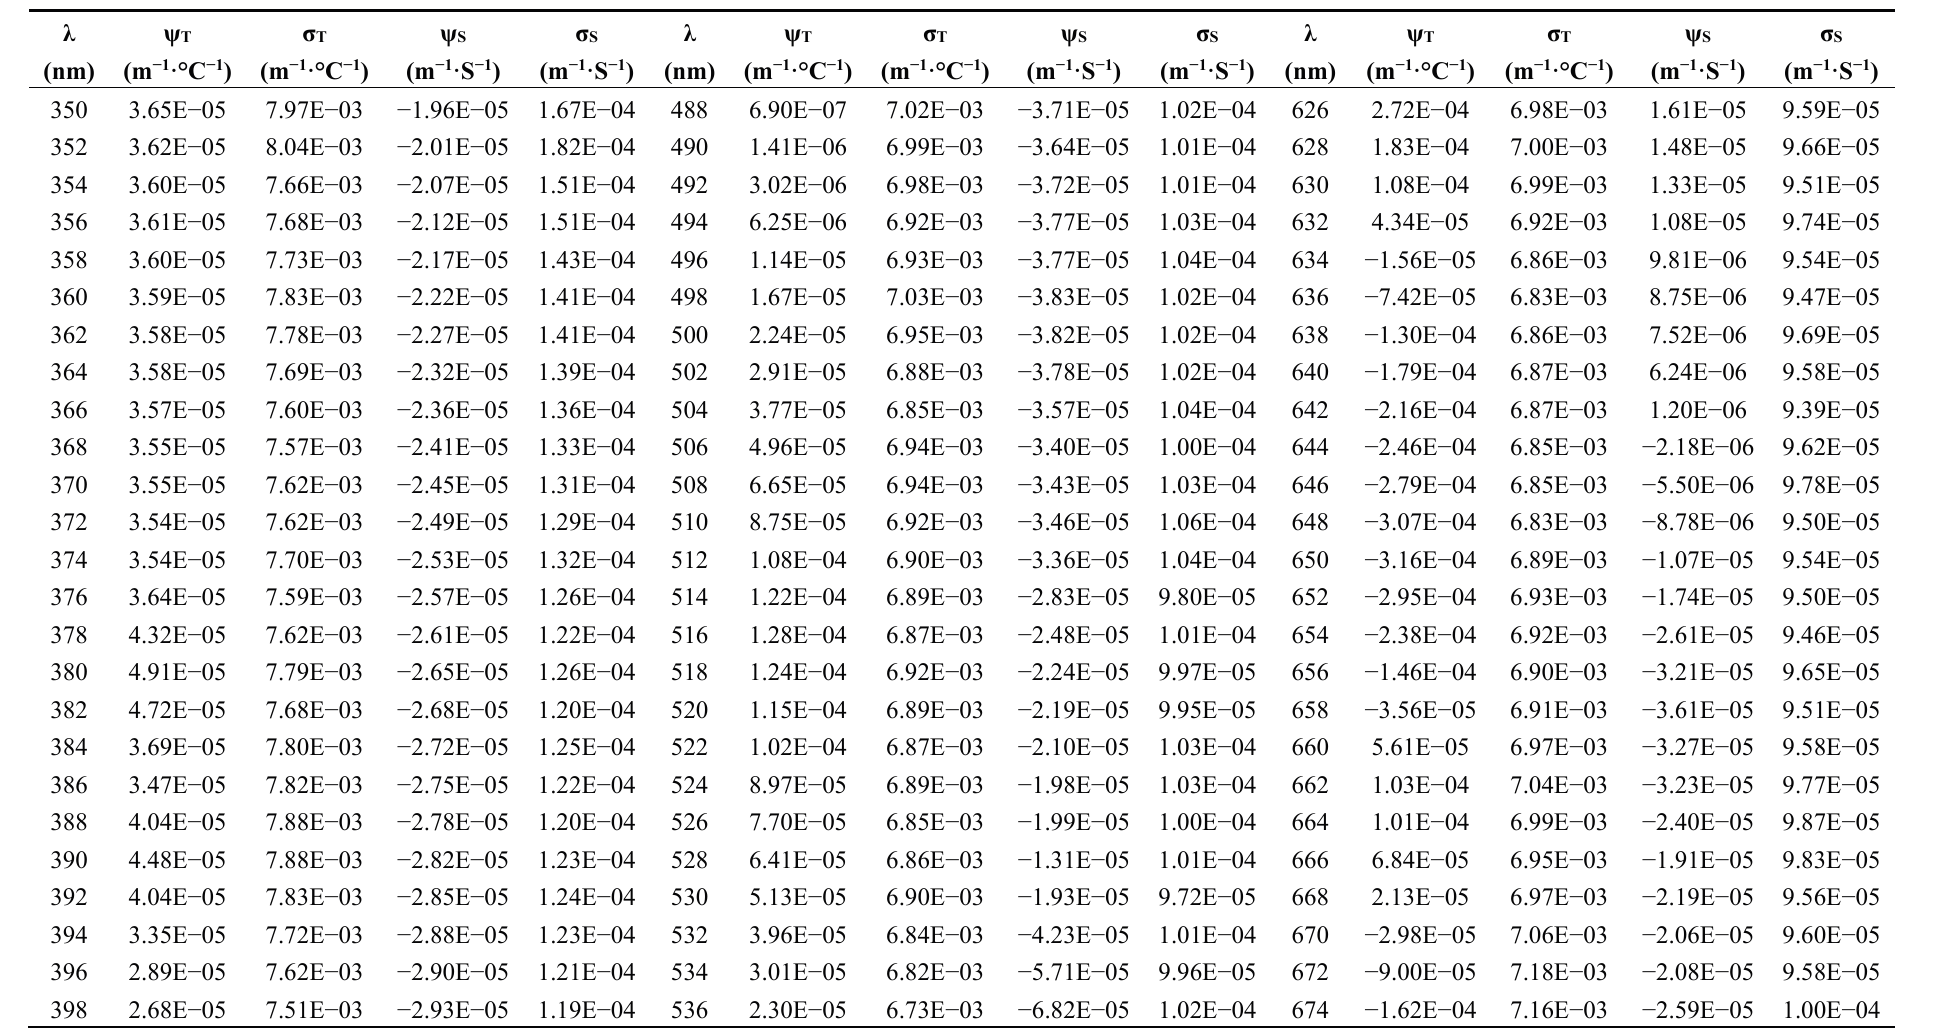
Table A1. Hyperspectral temperature ( ψ i T , m − 1 °C − 1 ) and salinity ( ψ i S , m − 1 · S − 1 ) dependencies for the attenuation of pure water measured with